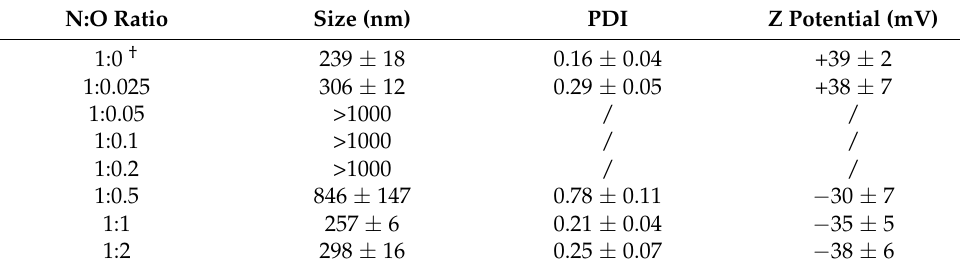
Table 1. Chemico-physical characteristics of NPs.